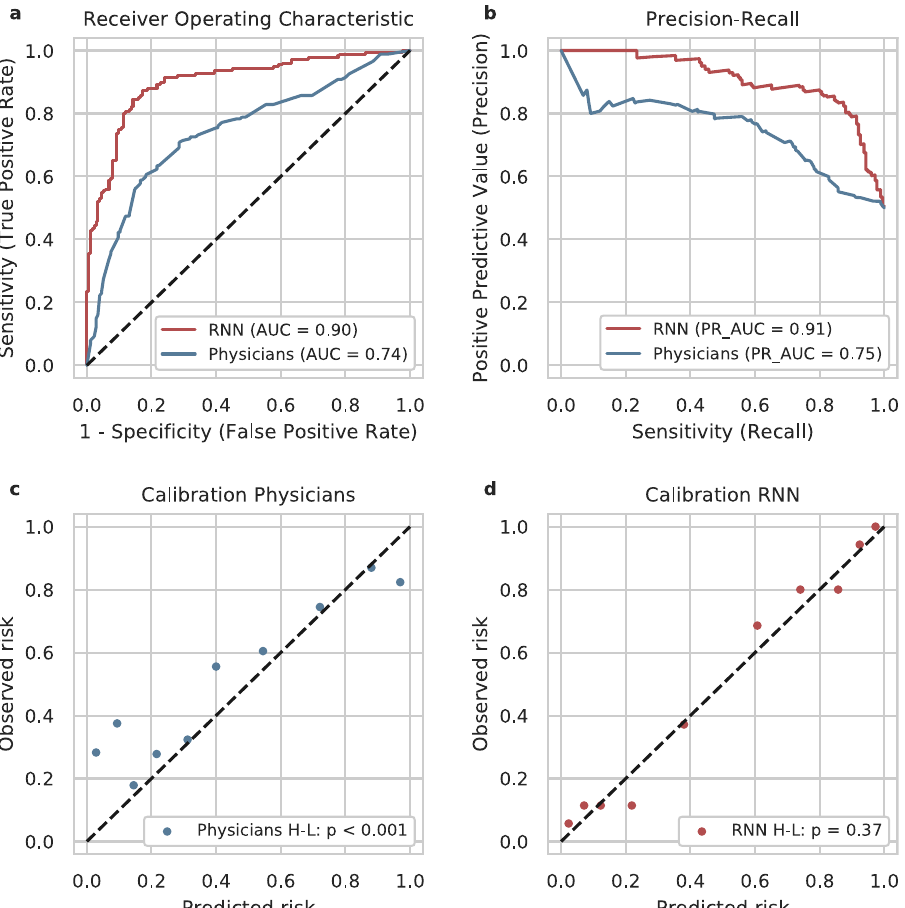
Fig. 2 Discrimination and calibration of the predictions of recurrent neural network (RNN) and physicians. a receiver operating characteristics (ROC), b precision-recall curve , c calibration of physicians , d calibration of RNN. AUC area under curve. H-L